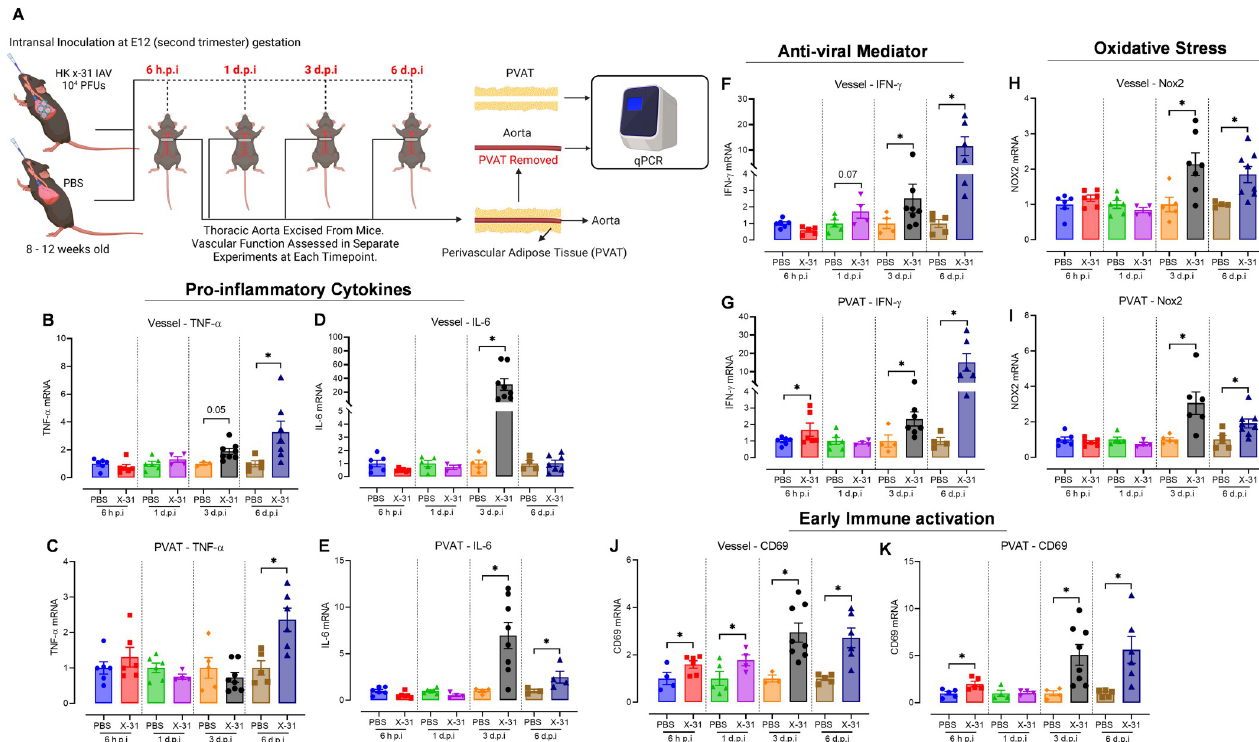
Fig 3. IAV induces an inflammatory and oxidative stress phenotype in both the arterial wall and PVAT in pregnant mice. Eight-to-twelve-week-old pregnant (E12 gestation) C57BL/6 mice were intranasally inoculated with PBS or Hk-x31 (X-31; 10 4 PFU) for vessel wall and PVAT tissue inflammatory and oxidative stress mRNA transcripts assessment at 6 h, or 1, 3 and 6 d.p.i. (A) Schematic of infection schedule and experiments (created with BioRender.com) (B —E) Vessel wall and PVAT gene expression of pro-inflammatory cytokines TNF- α and IL-6. (F—G) Antiviral mediator IFN- γ mRNA transcript gene expressions as determined via qPCR in the vessel wall and PVAT. (H—I) Vessel wall and PVAT gene expression of oxidative stress marker NOX2. (J—K) Early immune activation marker CD69 mRNA transcript gene expressions as determined via qPCR in the vessel wall and PVAT. Data are represented as mean ± SEM (pregnant PBS, n = 4–8; pregnant X-31, n = 4–8 of at least two independent experiments). All fold change calculations of the X-31 group were measured via qPCR, performed against the PBS group within its respective timepoint and normalised against RPS18. Statistical analysis was performed using unpaired t-test against their respective PBS control. � P <